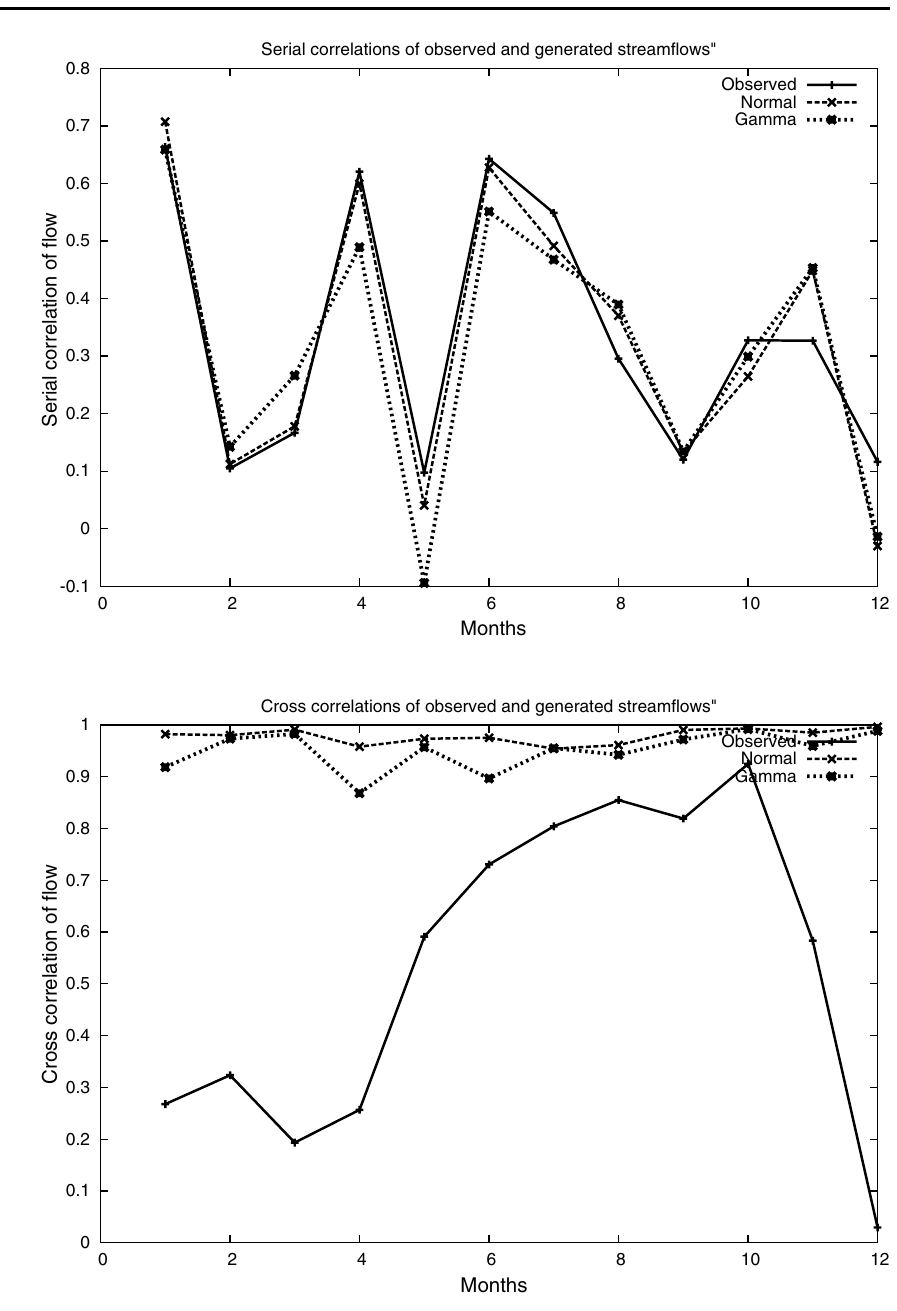
Fig. 9 Historical and generated monthly serial correlations of flows in Barakar River (single- site model)